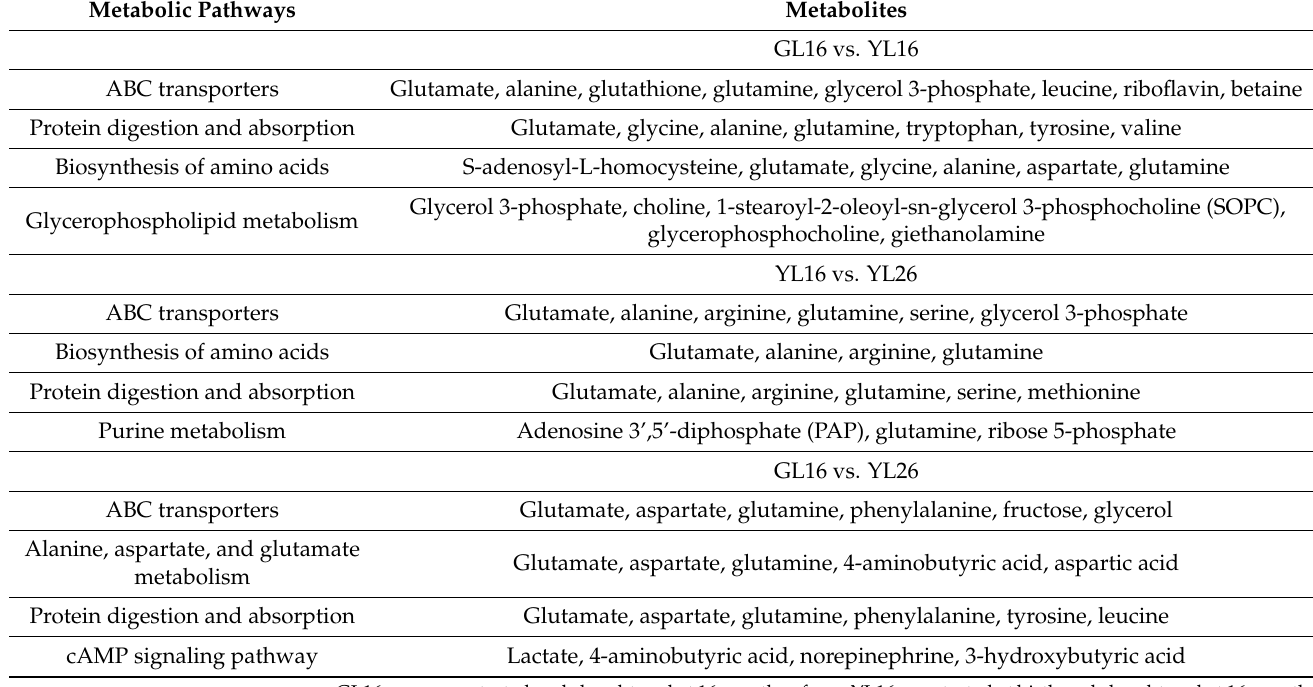
Table 4. DFMs from liver samples in the key differential enriched KEGG pathways (false discovery rate <